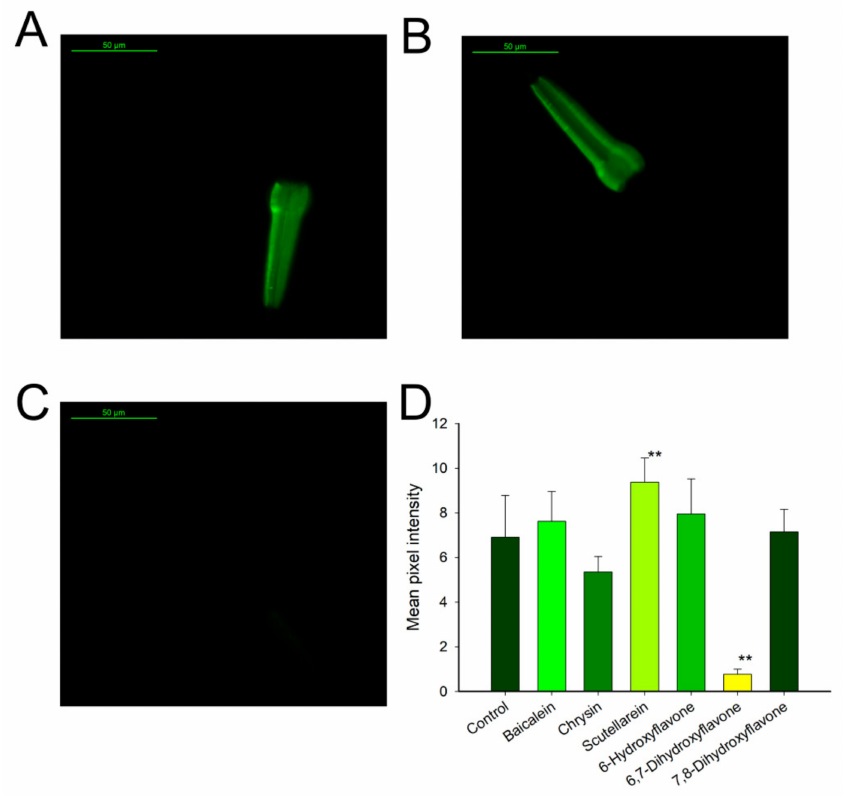
Figure 2. Flavonoids effect on Caenorhabditis elegans strain TJ375 ( hsp-16.2p::GFP ) model of oxidative stress resistance. ( A ) Representative image of a TJ375 control worm. ( B ) Representative image of a TJ375 worm treated with 100 µ M of baicalein. ( C ) Representative image of a TJ375 worm treated with 100 µ M of 6,7-dihydroxyflavone. ( D ) Quantification of the effect of pre-treatment with flavones in oxidative stress resistance measured through fluorescence integration. Data are represented as mean ± S.D, n > 10; two independent experiments were performed; ** significant at p ≤ 0.05 by ANOVA test. Scale bar: 50 µ m, magnification 40 ×